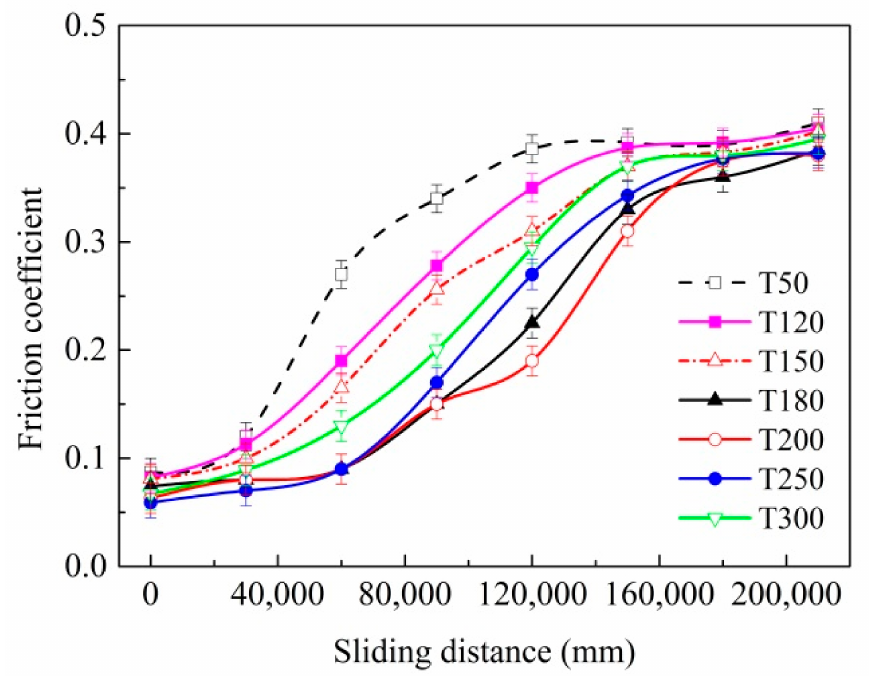
Figure 10. Effect of deposition temperature on the average friction coefficient of coated samples at the sliding speed of 260 mm/s and applied force of 10